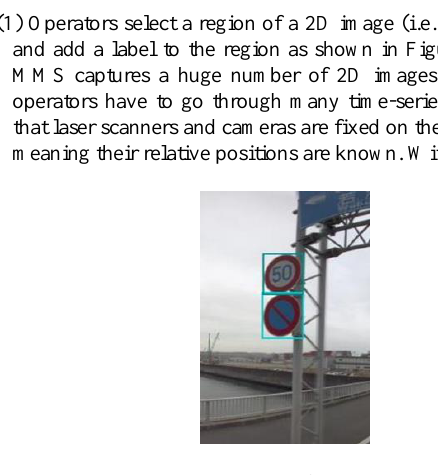
Figure 1. Labelling of a camera image